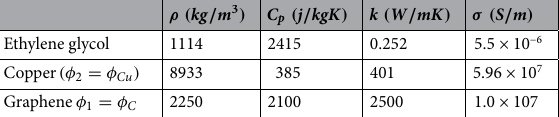
Table 1. The experimental values of base fluid (ethylene glycol) and nano particulates (copper and graphene 58 .